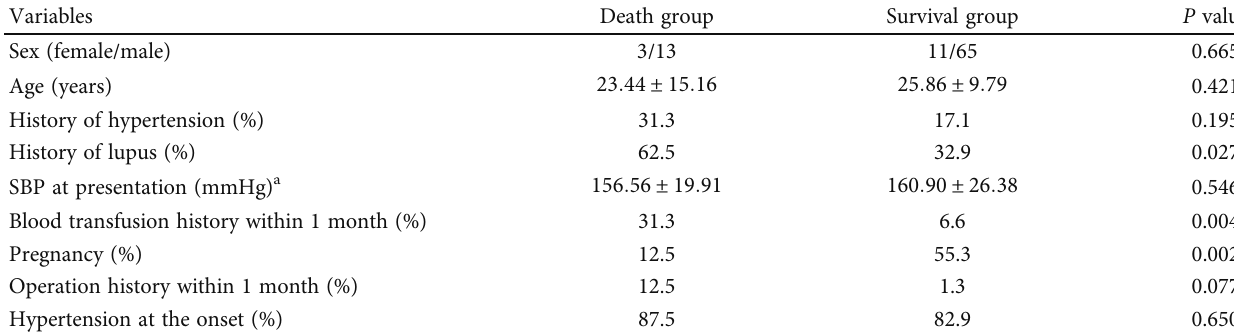
Table 1: Basic characteristics and past